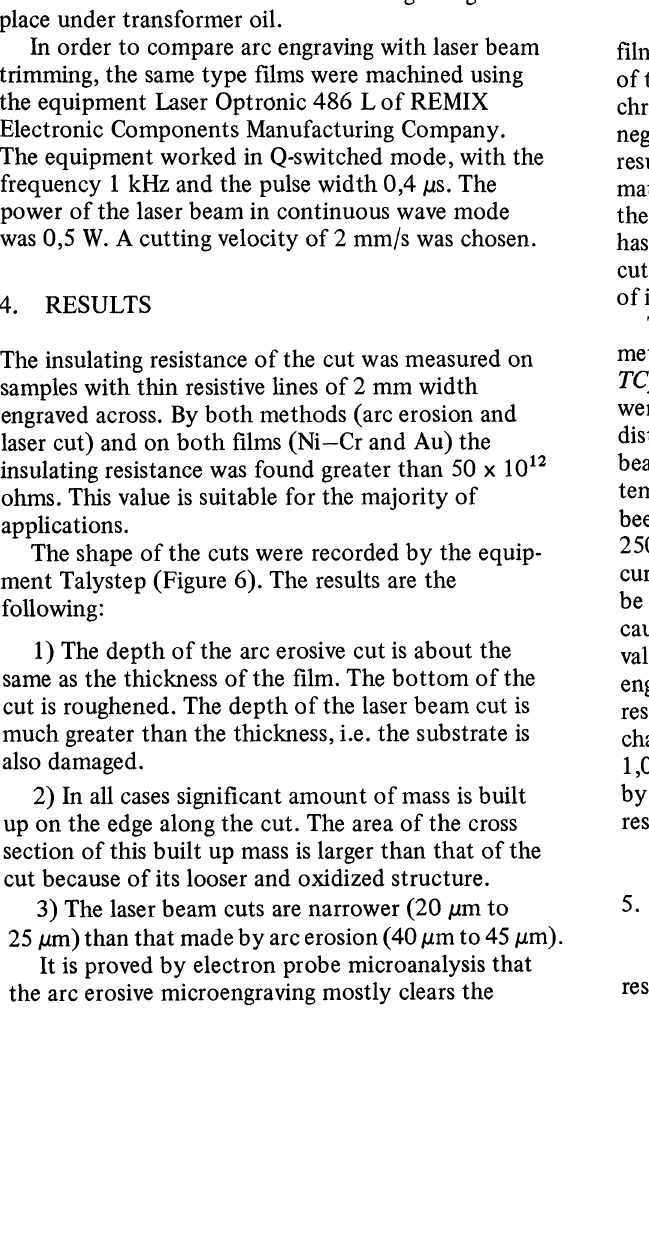
FIGURE 8 The influence of trimming on the TC